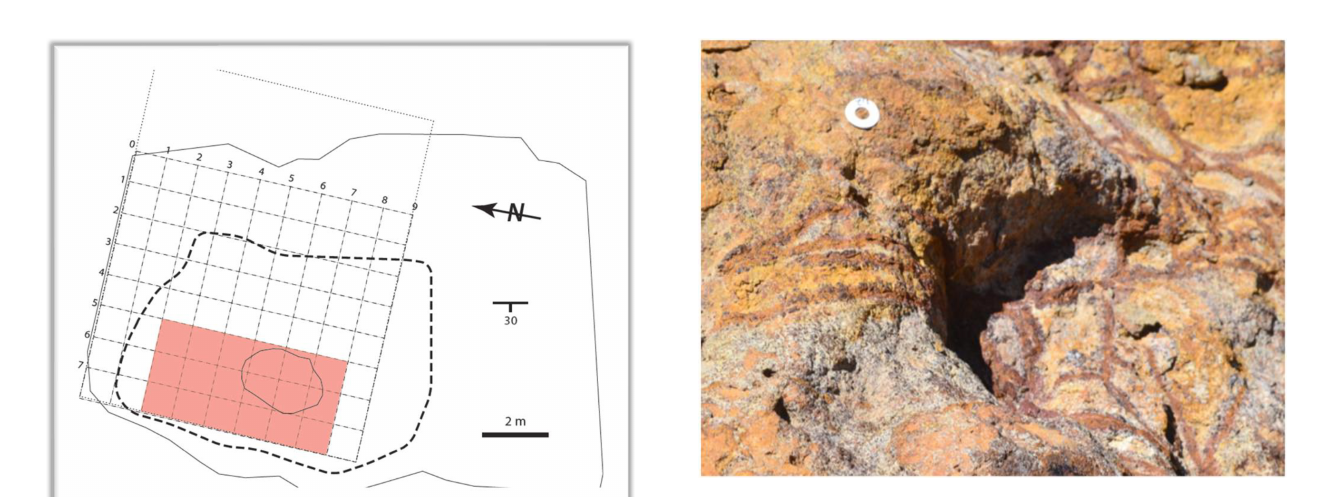
Figure 5. This photo shows the circular mark used to indicate the intersection of two 1m spaced grid lines in the survey